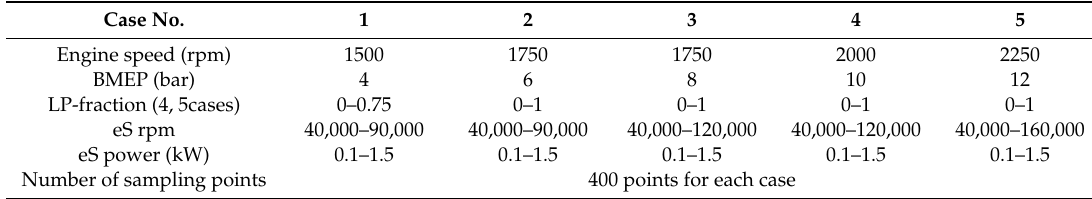
Table 4. Sampling ranges for Latin hypercube sampling of design of experiment.